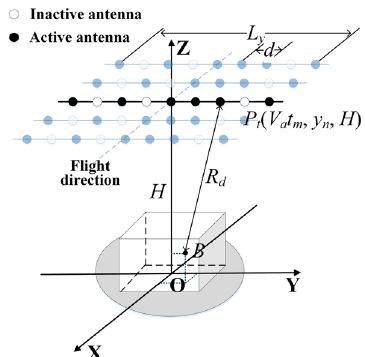
Fig. 1 Imaging geometric relationship of 3D sparse array